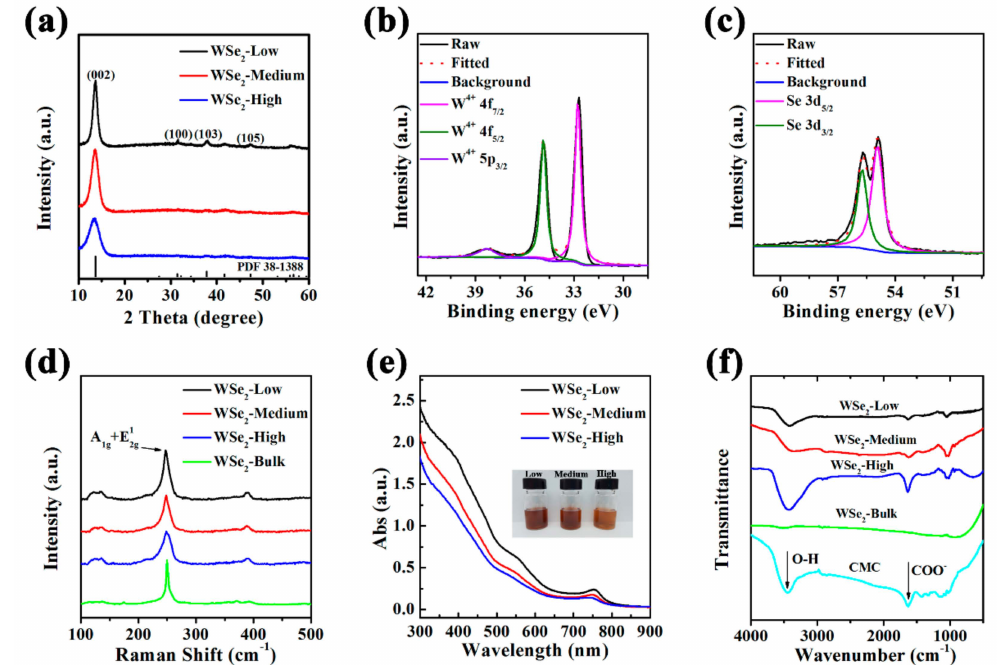
Figure 3. ( a ) XRD patterns of WSe 2 NSs with different sizes. XPS spectra of WSe 2 NSs (WSe 2 –Low) for ( b ) W 4f and W 5p, and ( c ) Se 3d. ( d ) Raman spectra of bulk WSe 2 and WSe 2 NSs with different sizes. ( e ) UV–vis–NIR absorption spectra and photos of WSe 2 NSs aqueous dispersions (inset). ( f ) FT–IR spectra of WSe 2 NSs, bulk WSe 2 , and